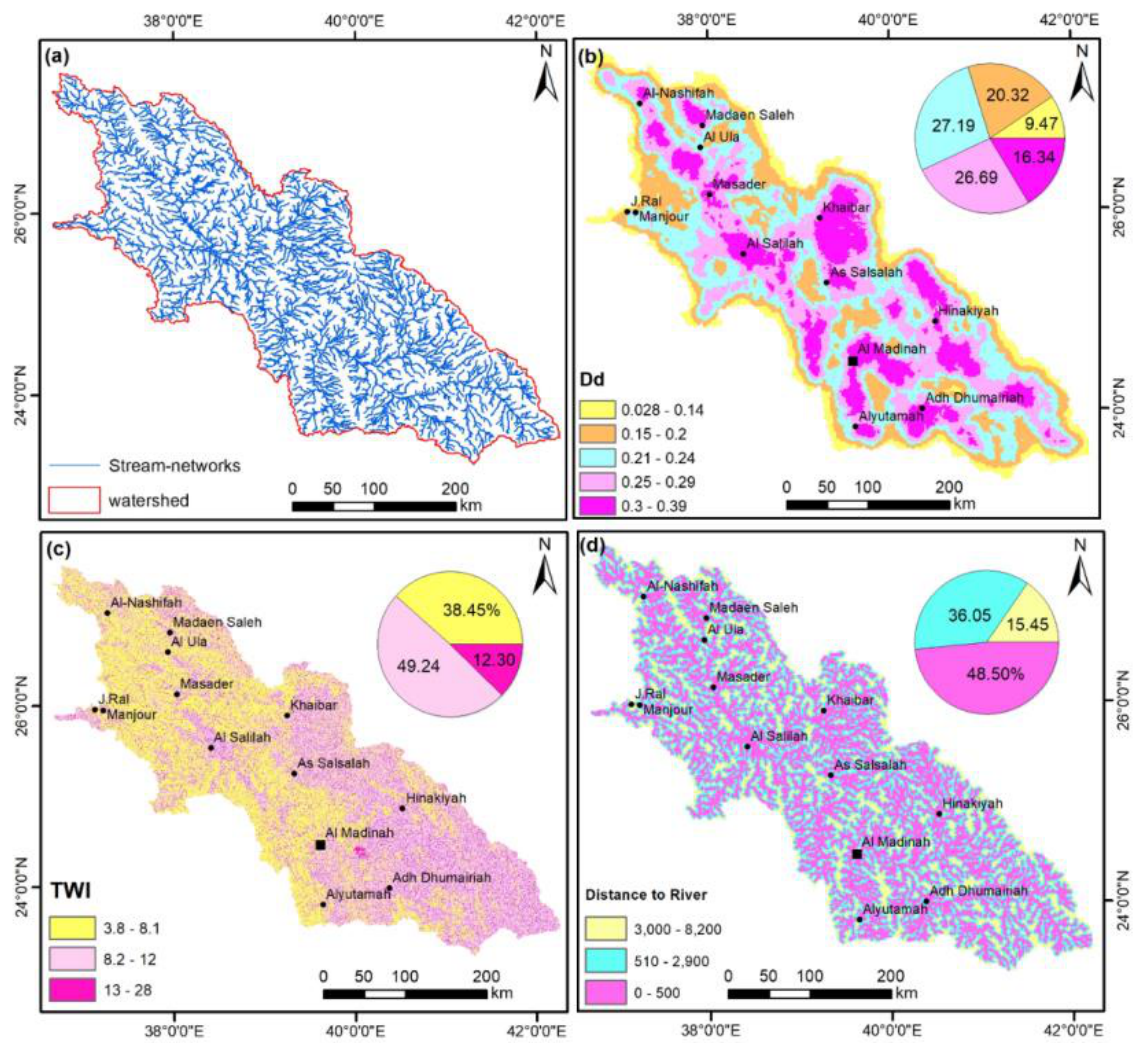
Figure 4. Hydrologic factors; ( a ) drainage-networks; ( b ) Dd; ( c ) TWI; ( d ) distance to river.